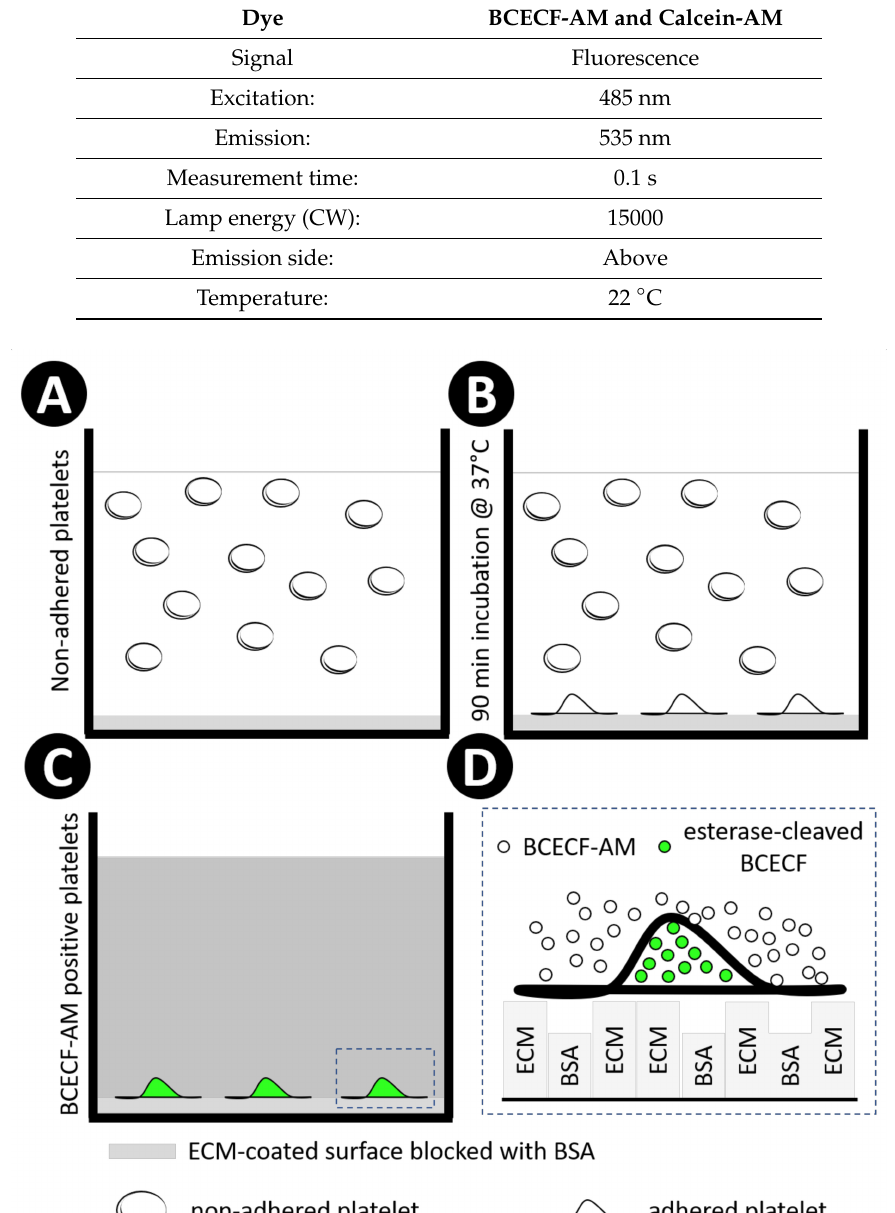
Table 3. Plate reader parameters for BCECF-AM and Calcein-AM.